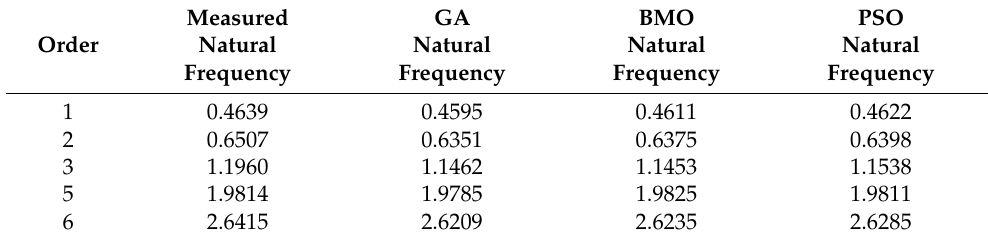
Table 3. Comparison of optimization results of the cable-stayed bridge (Unit: Hz).